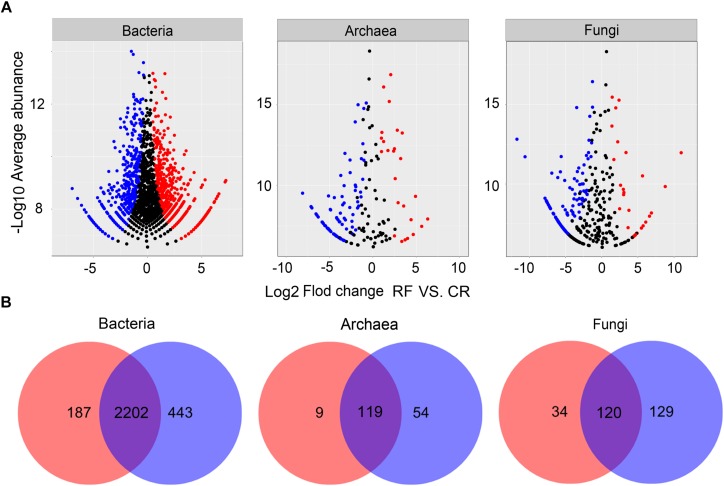
(A) Volcano plots illustrating OTUs that were significantly enriched (red) and depleted (blue) by RF compared with CR as determined by differential abundance analysis. Each point represents an individual OTU, and the Y-axis indicates the fold change in abundance. (B) Number of differential OTUs between each treatment. CR, conventional rice cultivation; RF, rice-frog cultivation.